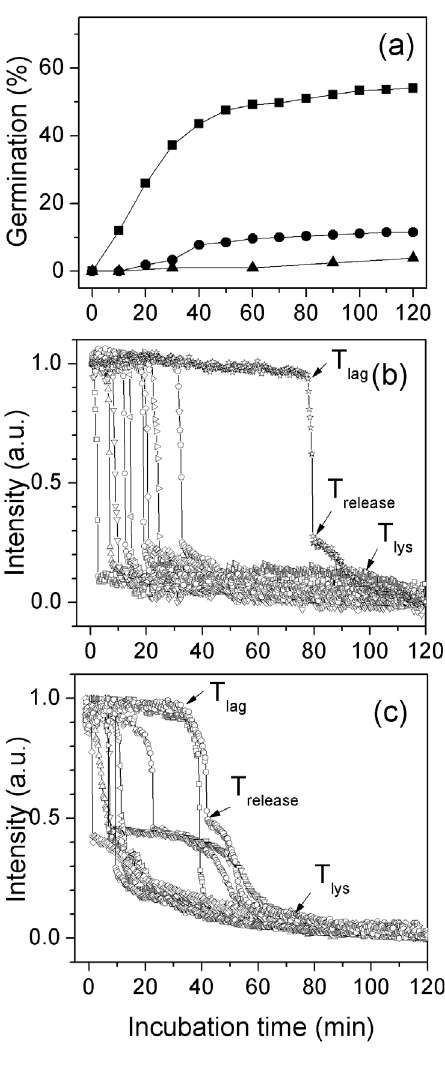
Figure 7. Germination of multiple individual G.stearothermo- philus spores with dodecylamine. Unactivated spores were germinated at various temperatures with 1 mM dodecylamine in 10 mM sodium phosphate buffer (pH 8.0), and germination of $ 470 N individual spores was monitored by DIC microscopy. Germination at ) and 45 u C ( m ) was shown in (a). Kinetics of 65 u C ( & ), 55 u C ( germination of ten individual spores at 65 u C (b) or 55 u C (c) was given in (b,